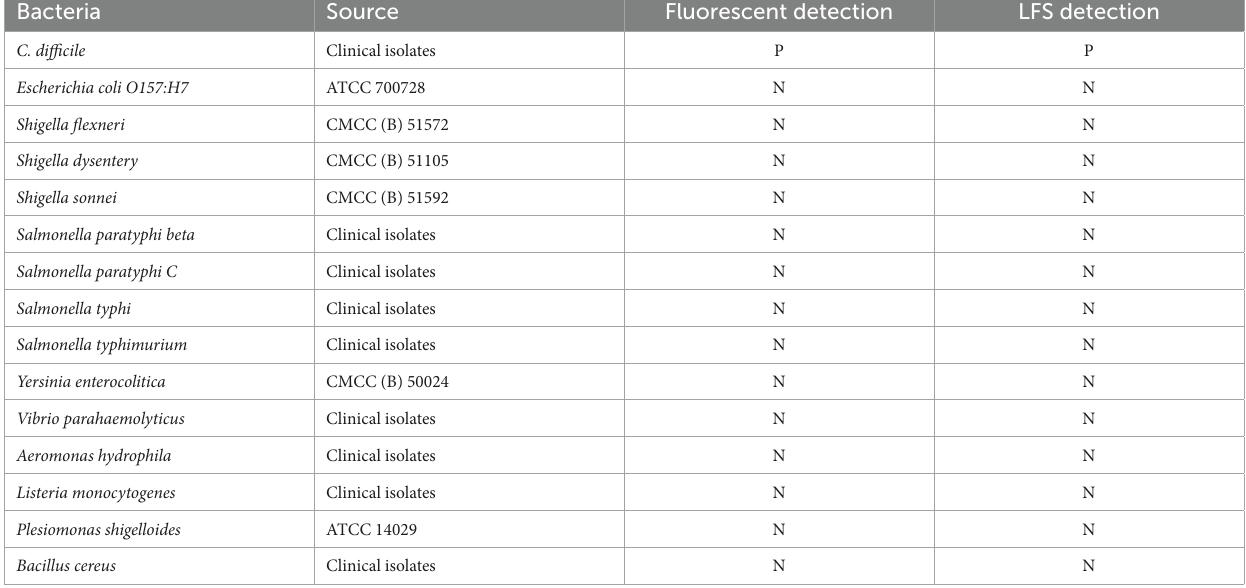
TABLE 1 Bacterial strains involved in this